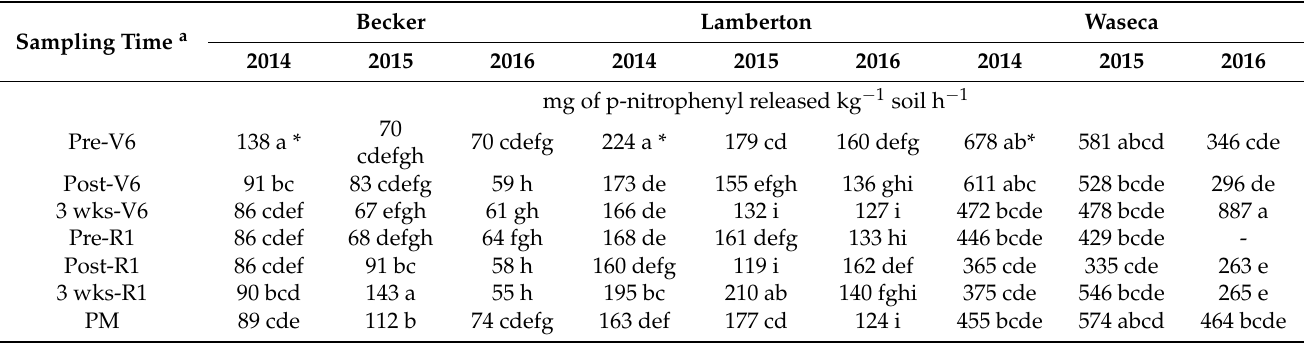
Table 7. In-season arylsulfatase activity at Becker, Lamberton, and Waseca from 2014 to